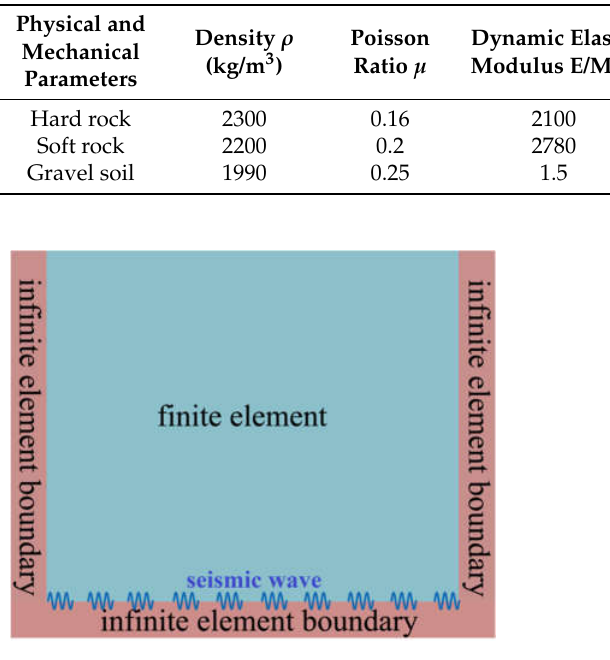
Figure 6. Schematic diagram of the boundary conditions of the numerical model. Table 1. Physico-mechanical parameters of the material parameters of the sites [9,20].